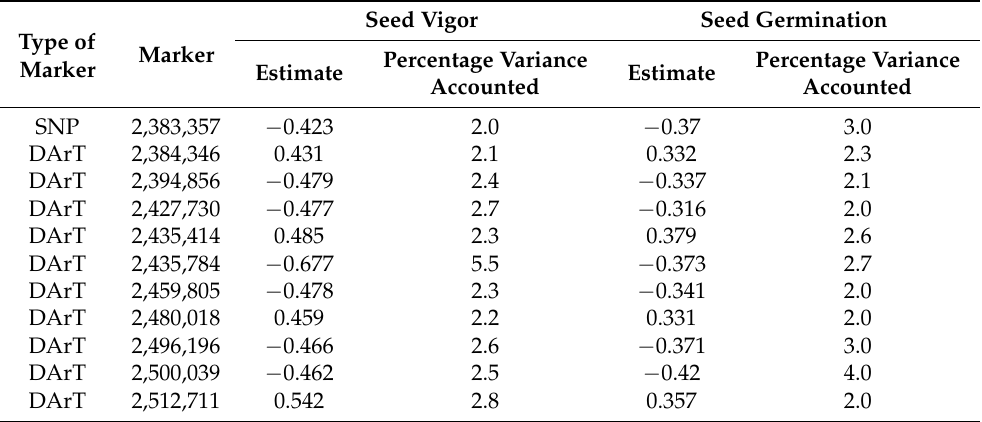
Table 2. Molecular markers of SilicoDArT and SNP significantly (LOD > 3.0) related to both observed traits: seed vigor and seed germination (significant associations selected at p < 0.05 with correction for multiple testing using the Benjamini–Hochberg method).